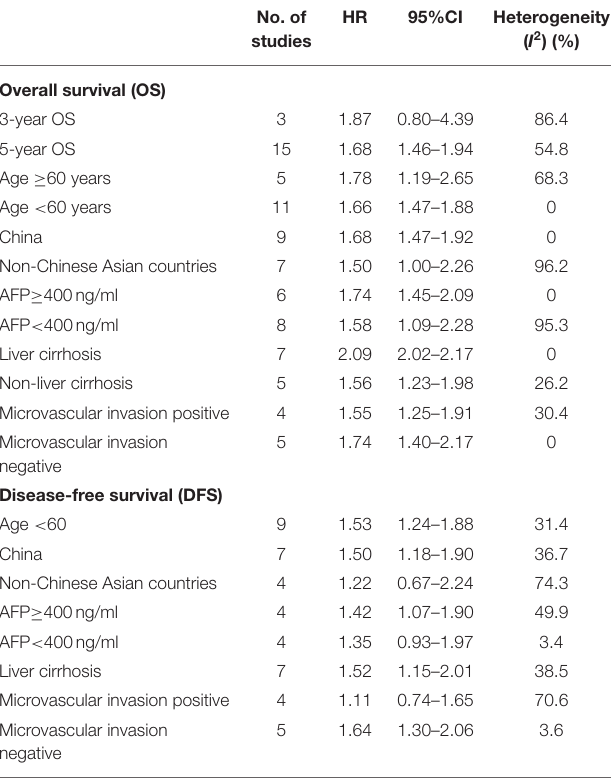
factor in macrovascular invasion negative patients (HR, 1.48; TABLE 2 | Subgroup analysis of the hepatocellular carcinoma (HCC) rupture on the prognosis of patients with HCC. No. of HR 95%CI Heterogeneity studies ( I 2 ) (%)